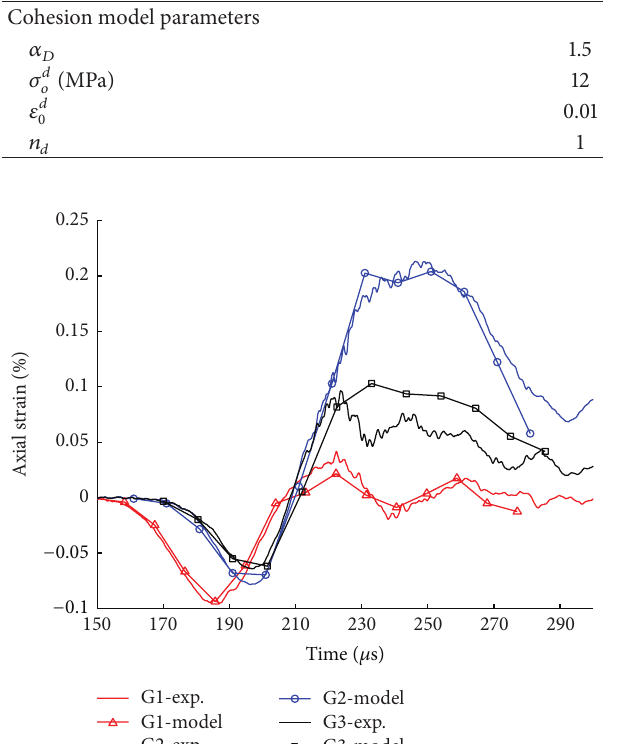
Figure 10: Finite element and experimental results from the spalling test for axial strain.